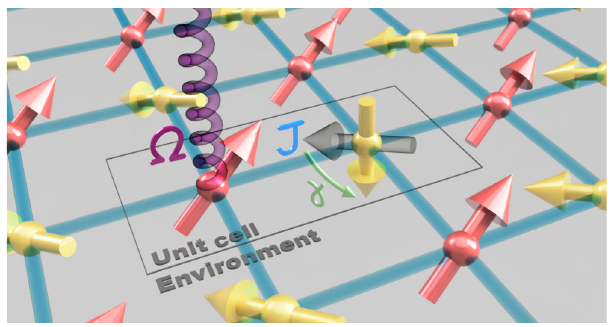
FIG. 1. Open quantum lattice model of interacting spins. Nearest-neighbor spins are coupled via a hopping J and interact with an external bath via a coherent drive Ω and/or a dissipative process γ . The open system can be modeled by describing the unit cell and its environment using a tensor network.